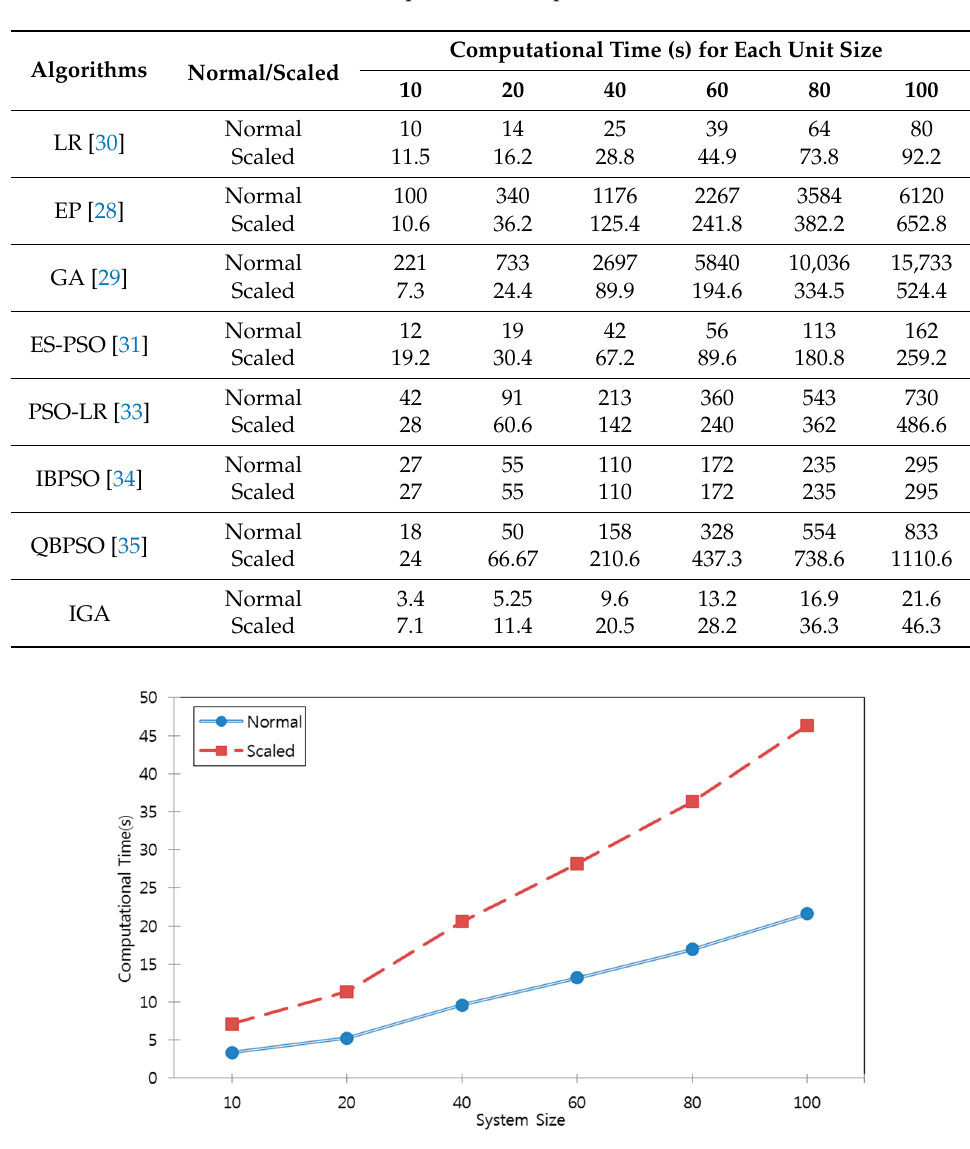
Figure 6. IGA computational time for each system size.